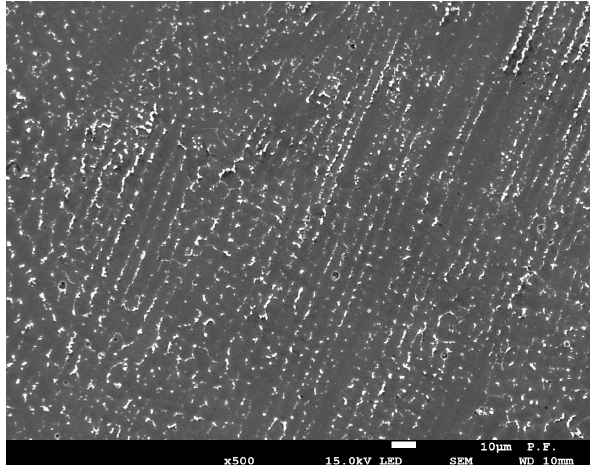
Figure 9: Microstructure of deposited Inconel 625 with